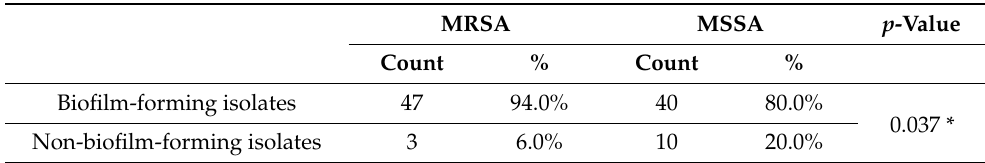
Table 1. Biofilm-formation in relation to methicillin susceptibility.